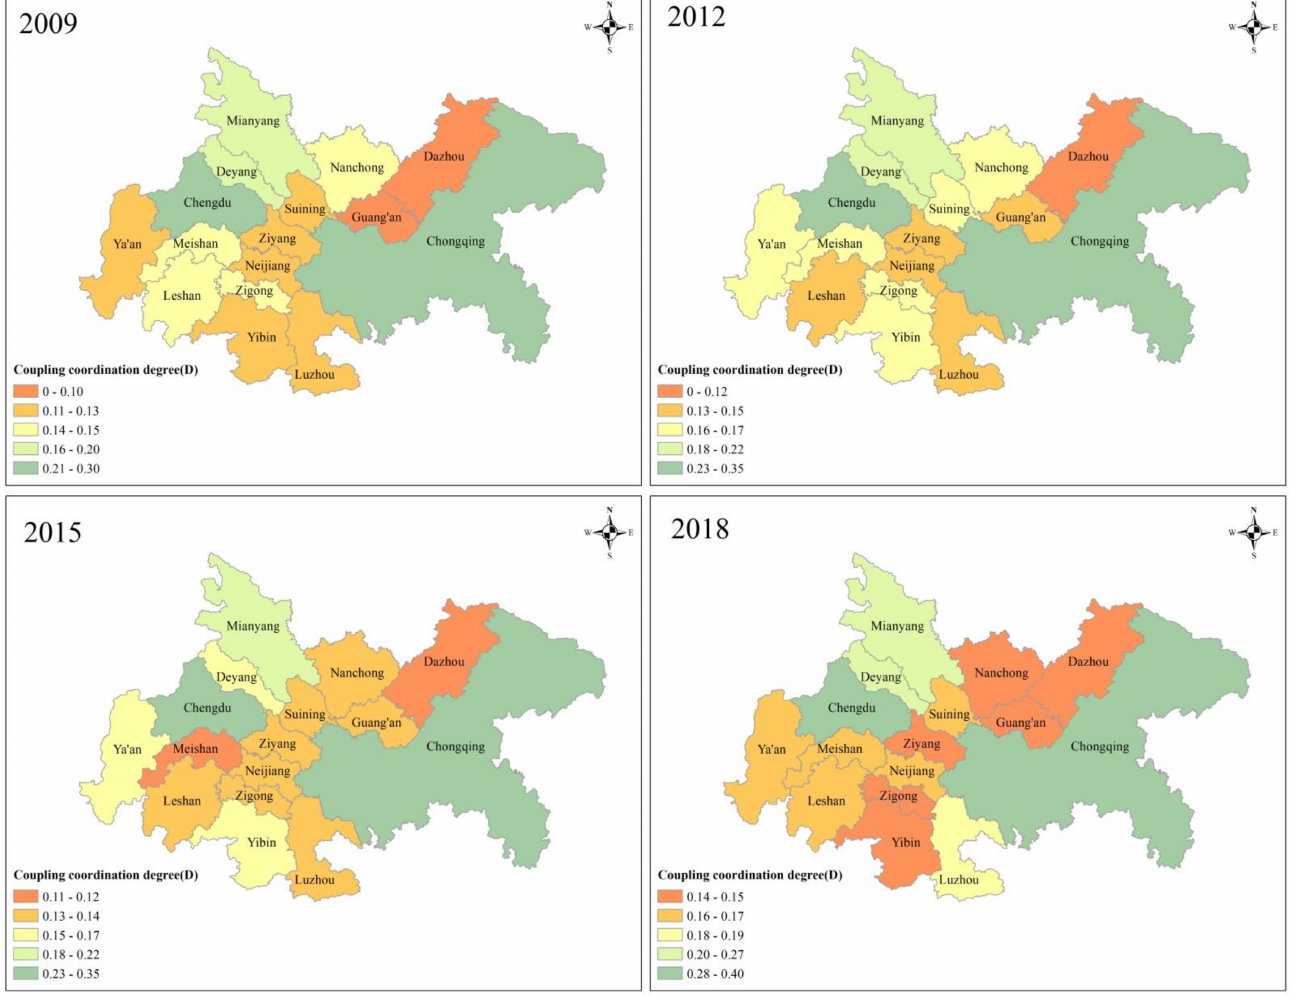
Figure 4. The spatial distributions of the CCD in the years 2009, 2012, 2015, and